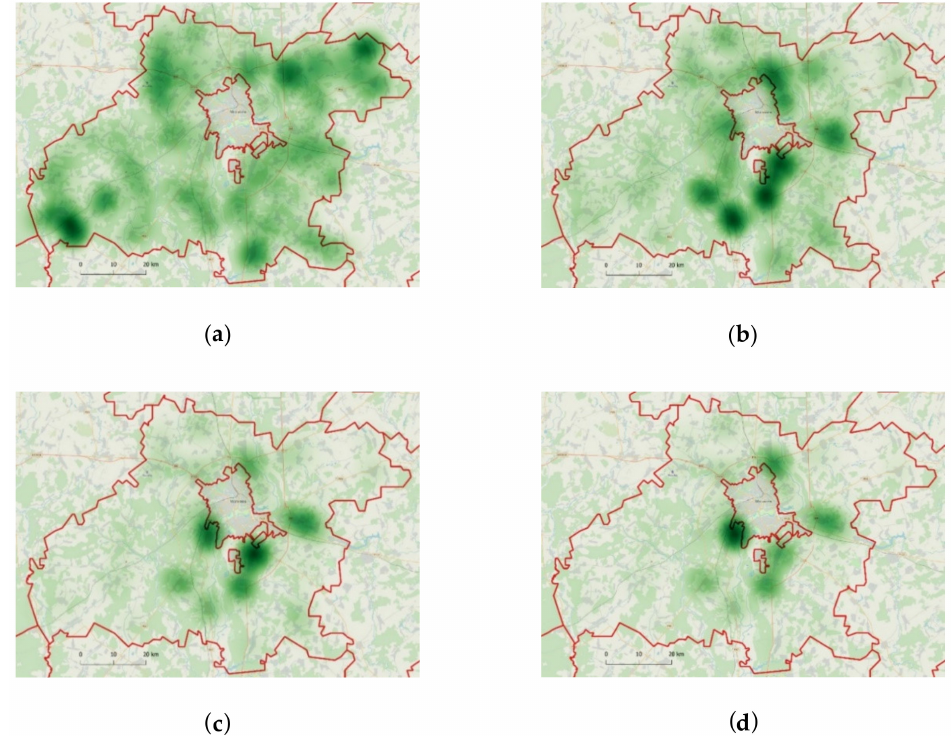
Figure 5. Rural population density within the current boundaries of the Mogilev district: ( a ) 1909; ( b ) 1990; ( c ) 2007; ( d ) 2018.